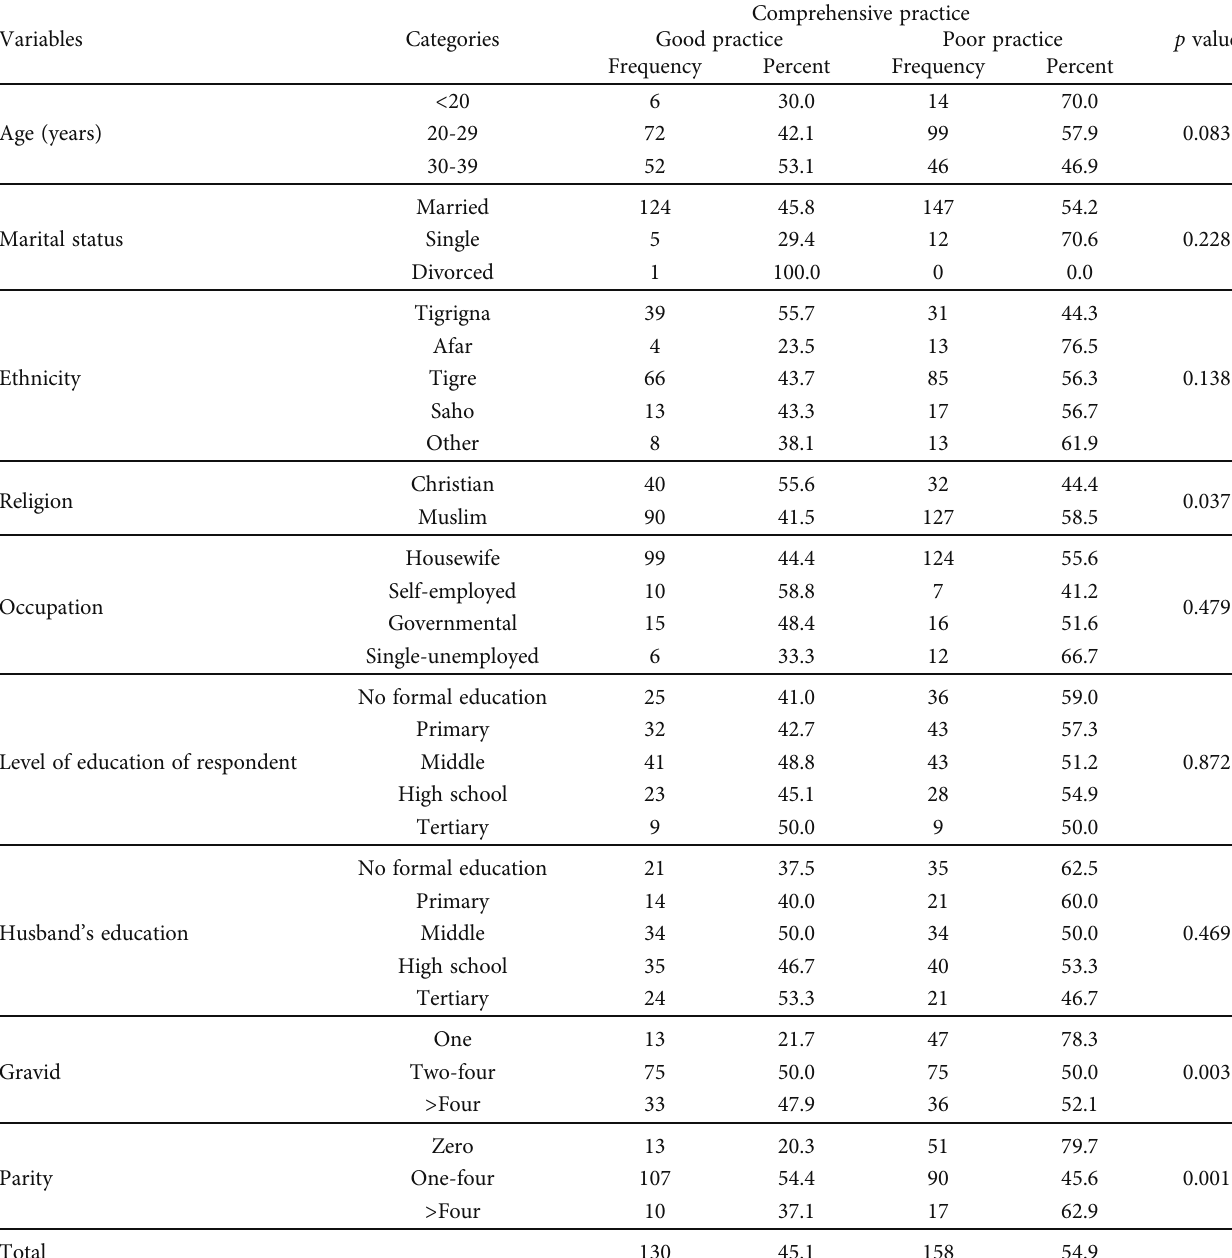
Table 6: Association between background characteristics and comprehensive practice of pregnant women in Amatere Health Center, 2019.